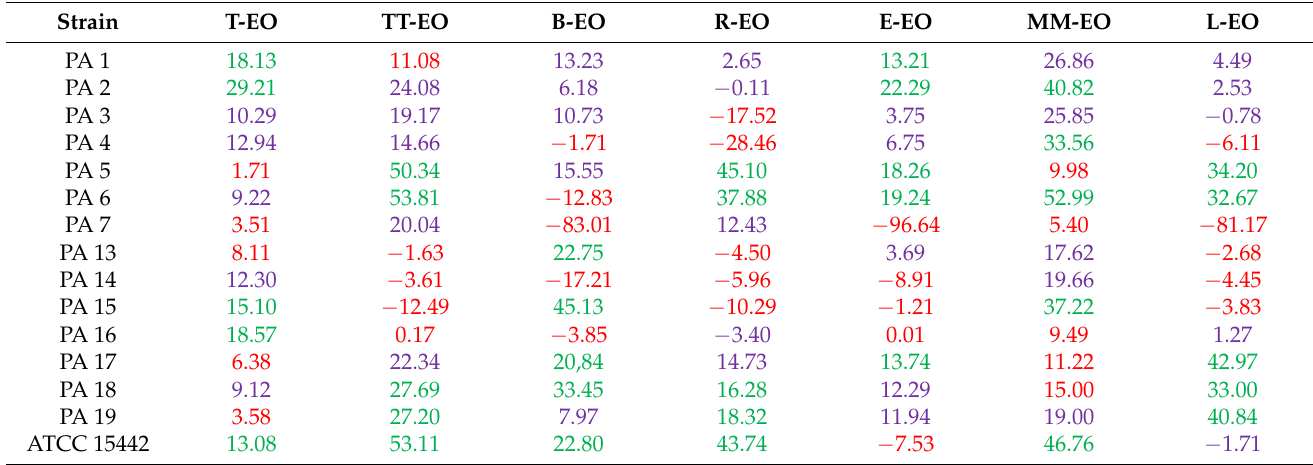
Table 4. Changes in biofilm-forming cells viability (%) of P. aeruginosa clinical (PA 1–7, PA 13–19) and the reference (ATCC 15442) strains after treatment with volatile non-emulsified EOs assessed with the AntiBioVol (antibiofilm activity of volatile compounds) method. T-EO, thyme oil; TT-EO, tea tree oil; B-EO, basil oil; R-EO, rosemary oil; E-EO, eucalyptus oil; MM-EO, menthol mint oil; L-EO, lavender oil. The strains were grouped by their susceptibility to the particular oil. The groups are marked as follows: red, lowest susceptibility; purple, moderate susceptibility; green, highest susceptibility among the tested strains. The negative values indicate an increase in biofilm-forming cells viability after their treatment with EOs in comparison to the growth control (untreated